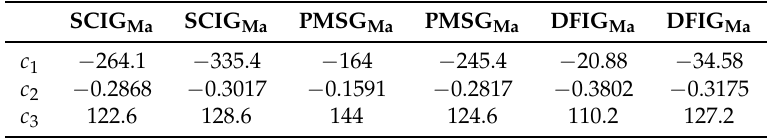
Table 4. Coefficients of the power function used to fit the trend line of the real